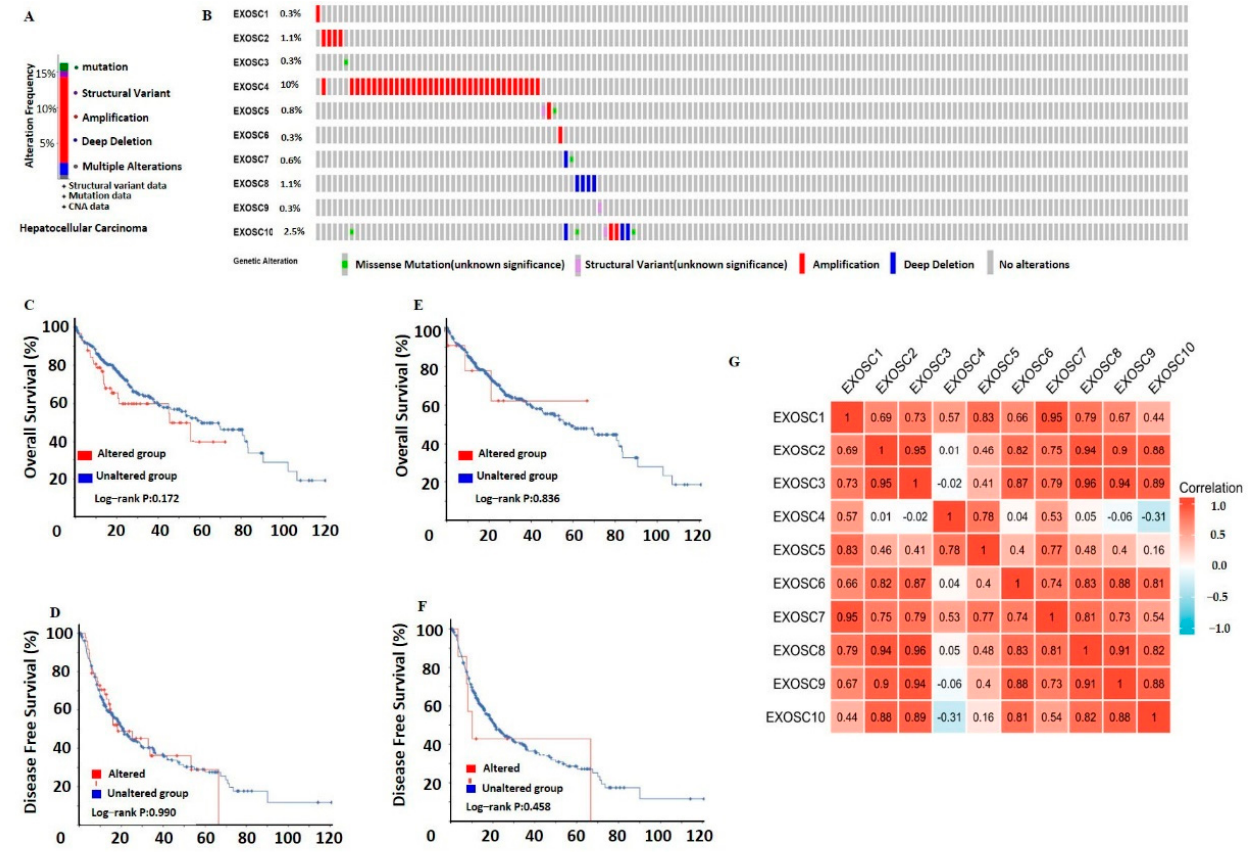
Figure 5. EXOSCs gene mutation and correlation analyses in HCC. ( A , B ) summary of alterations in different expressed EXOSCs in HCC. The genetic mutation of EXOSCs. ( C – F ) Correlation between